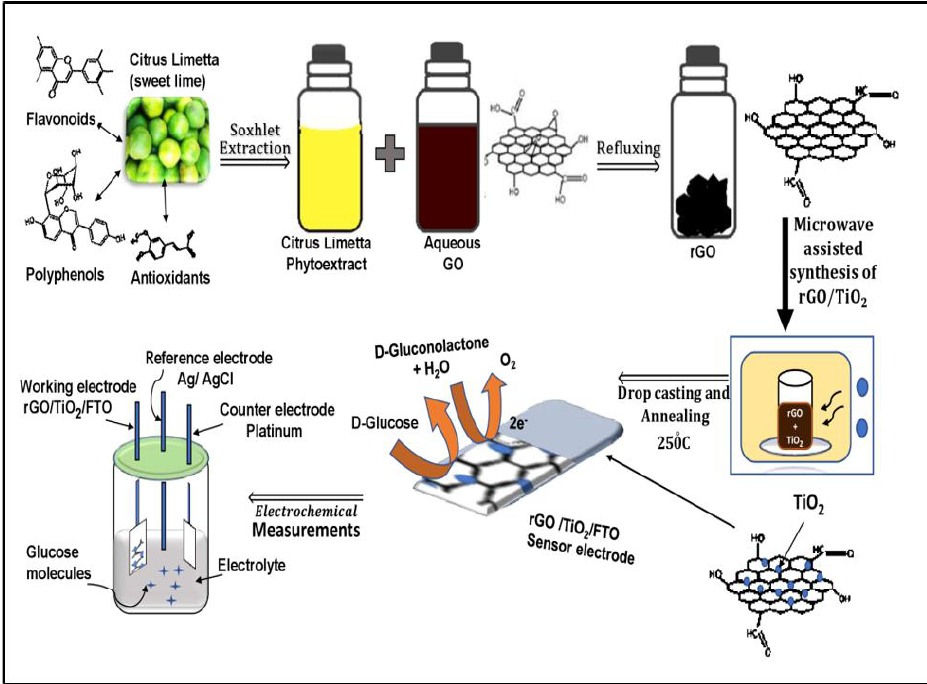
Figure 1. Mechanism of green reduction of GO and rGO/TiO 2 /FTO for glucose sensing application.